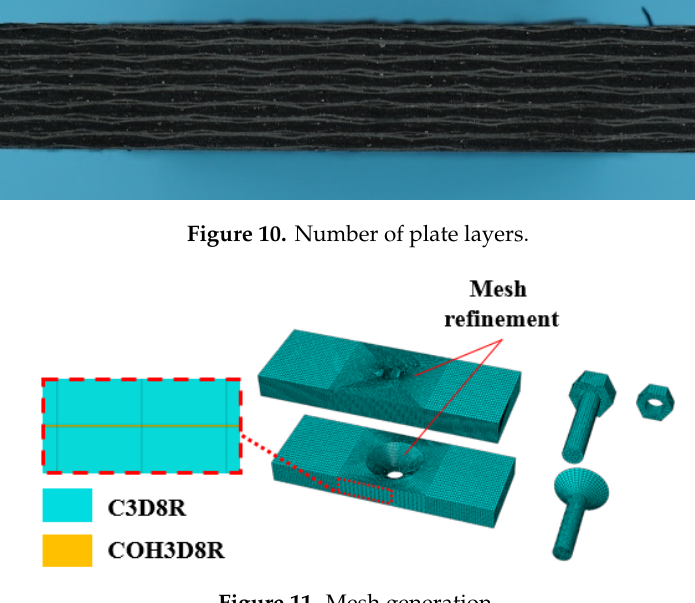
Figure 11. Mesh generation.